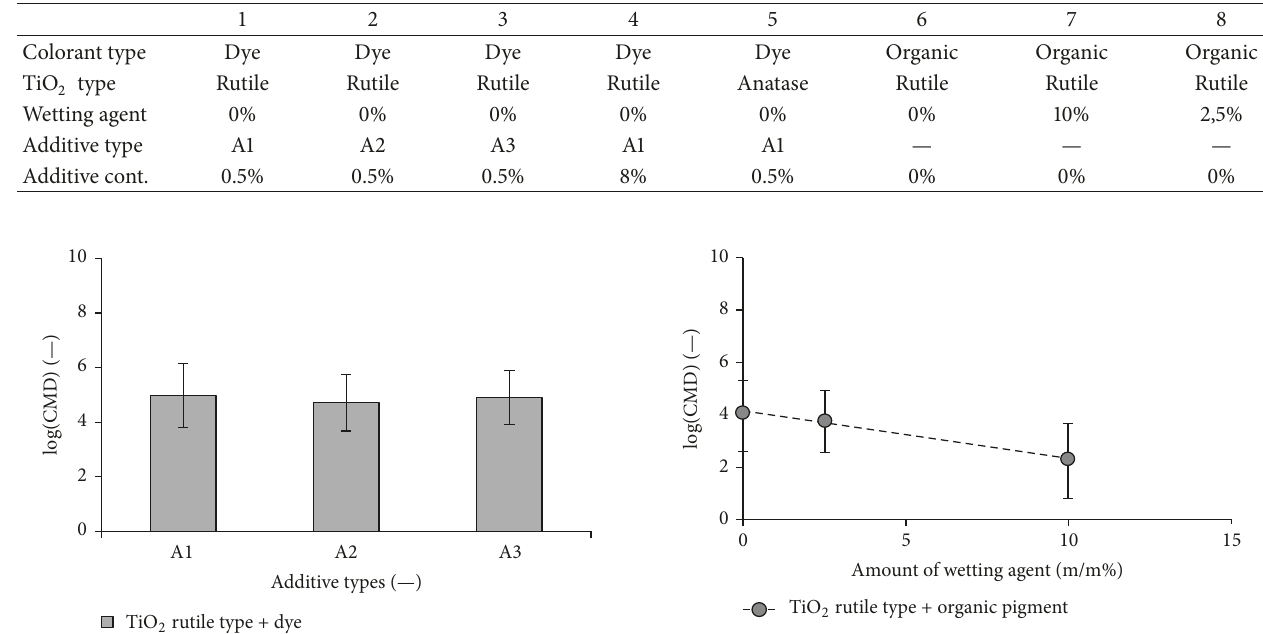
Table 3: The compositions of the masterbatches in the second test series.